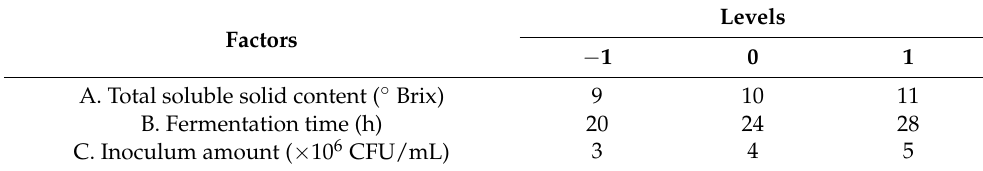
Table 2. Factors and levels of the